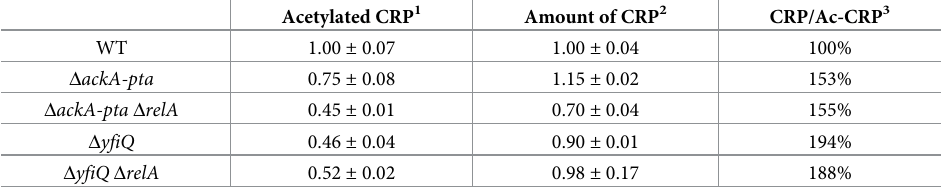
Table 1. YfiQ is required for CRP acetylation. Amount of CRP acetylated relative to WT in absence of acetyl-phos- phate and the KAT YfiQ was measured in M9 media supplemented with glycerol. Western blot can be found in S7 Fig.